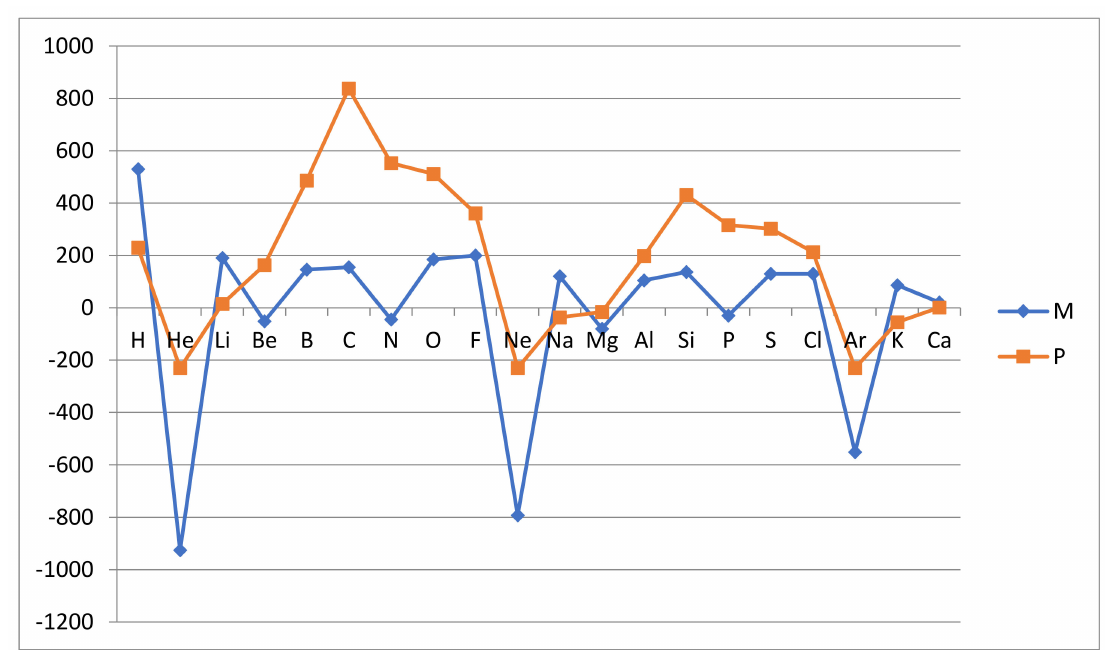
Figure 1. The atomic reactivities AR M (A) based on first ionization energies (diamonds) and AR P (A) based hydride atomization energies (squares) are shown in kJ/mol for 20 atoms from H to Ca.